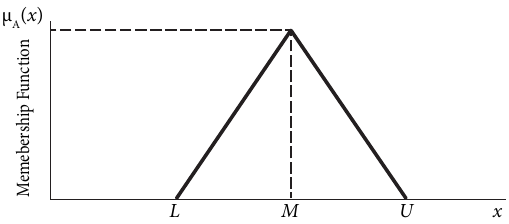
Fig. 1. Membership function of the triangular fuzzy number